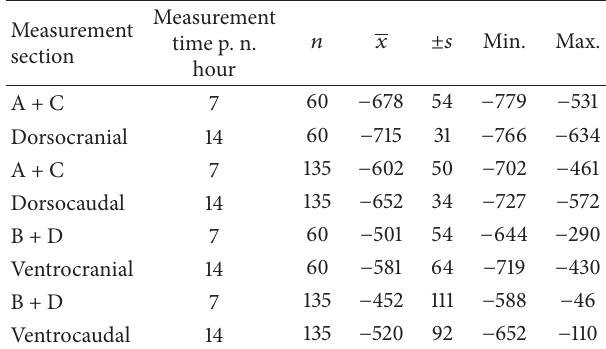
Table 7: X-ray absorption values (HU) in the pulmonary tissue of calves in group A comparing the seventh and fourteenth day of